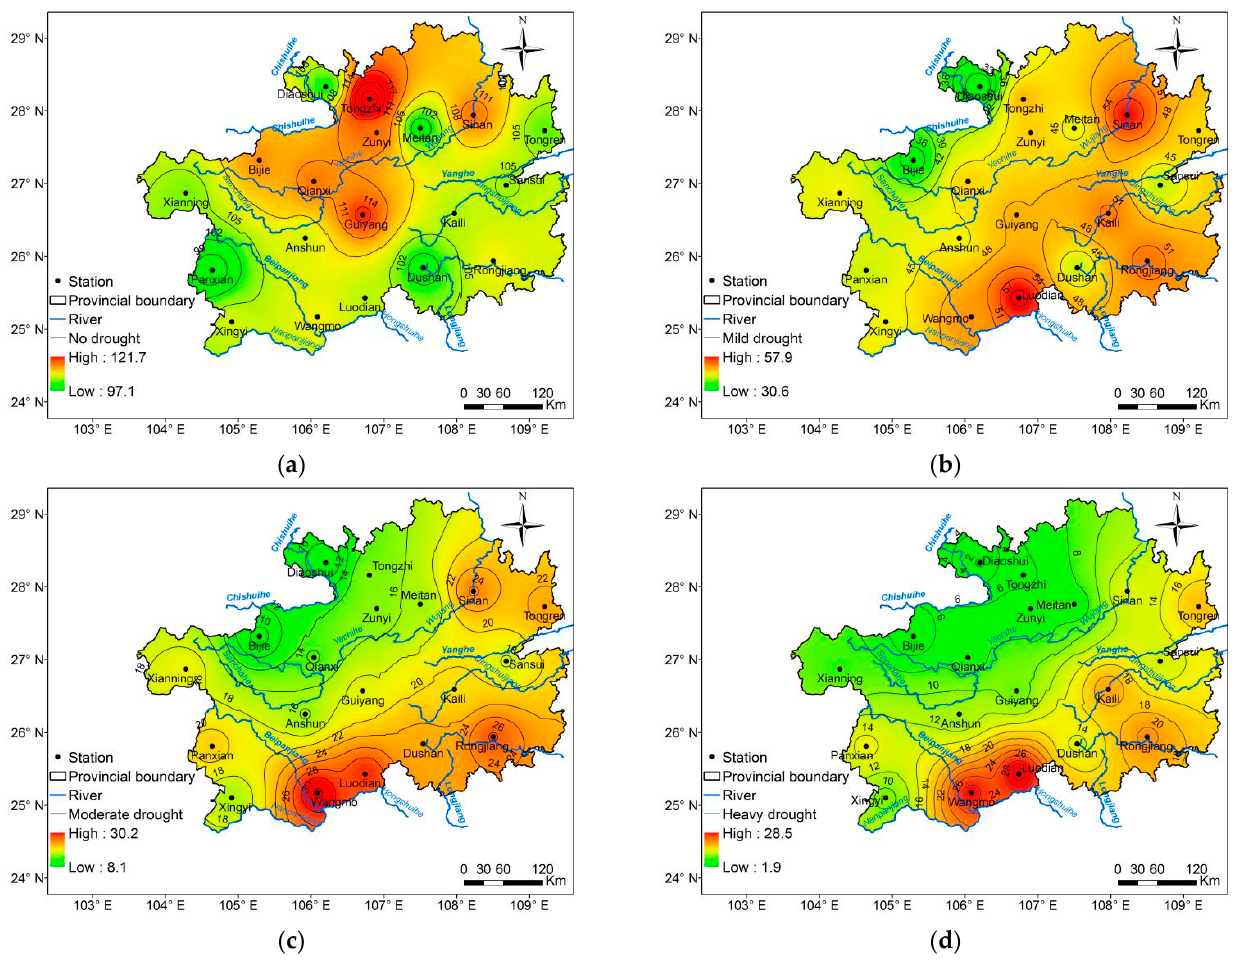
Figure 11. The spatial variations of ( a ) no drought, ( b ) mild drought, ( c ) moderate drought, ( d ) heavy drought.